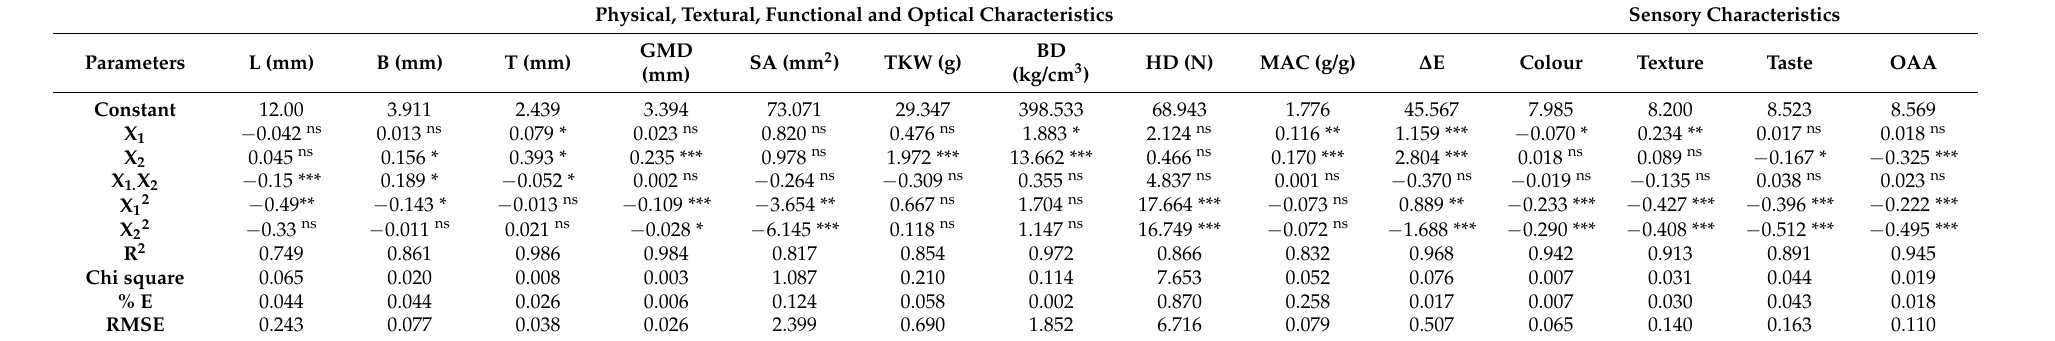
Table 3. Regression coefficients of fitted models with statistical